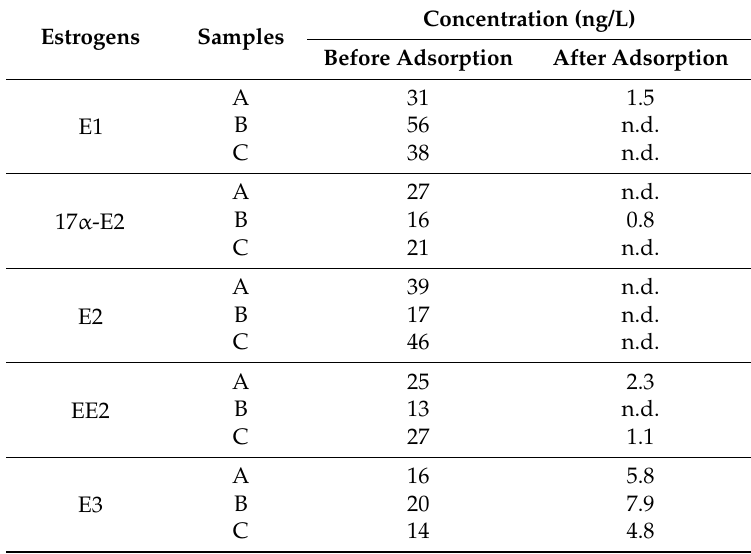
Table 3. Removal of estrogens in wastewater treatment plant (WWTP) effluent by using MGO. Estrogens